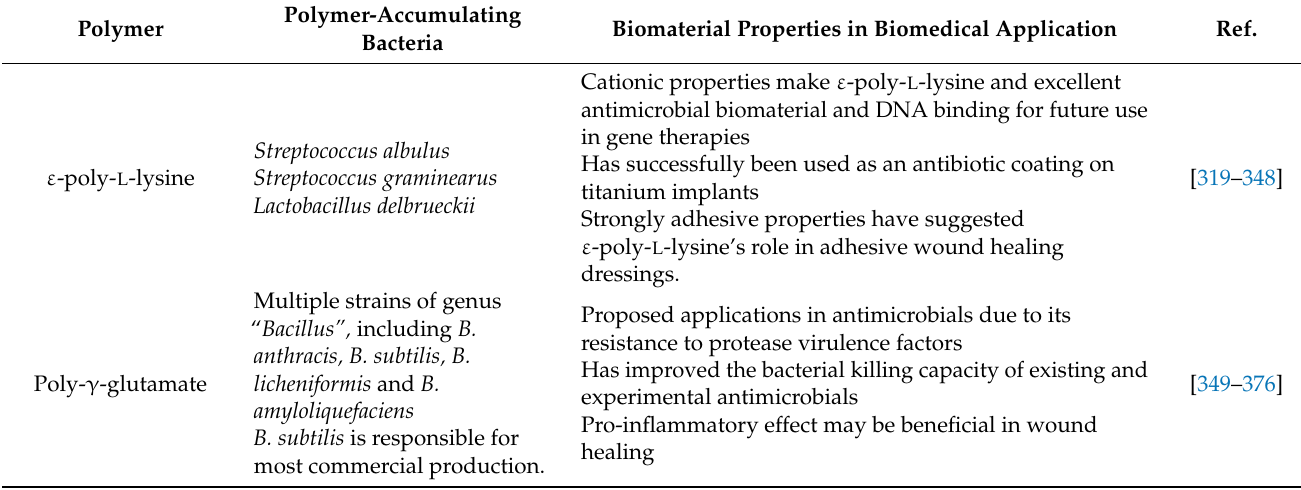
Table 4. Summary Table for Bacteria-Derived